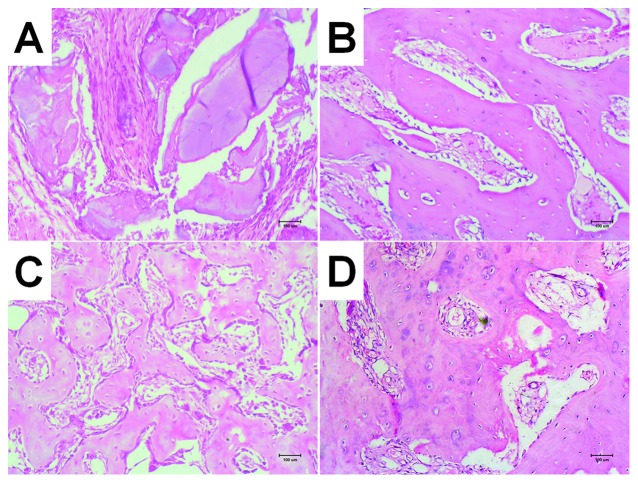
HE staining of ectopic bone formation in nude mice at 12 weeks (×100), Implant I can be seen partially degraded DBM stand, surrounded by fibrous connective tissue replaced; Implant II showed more mature bone structure of a small beam than other groups; both Implant III and IV showed small beam structure of bone with some cartilage-like structure partially visible, bone formation maturity lower than Implant II.